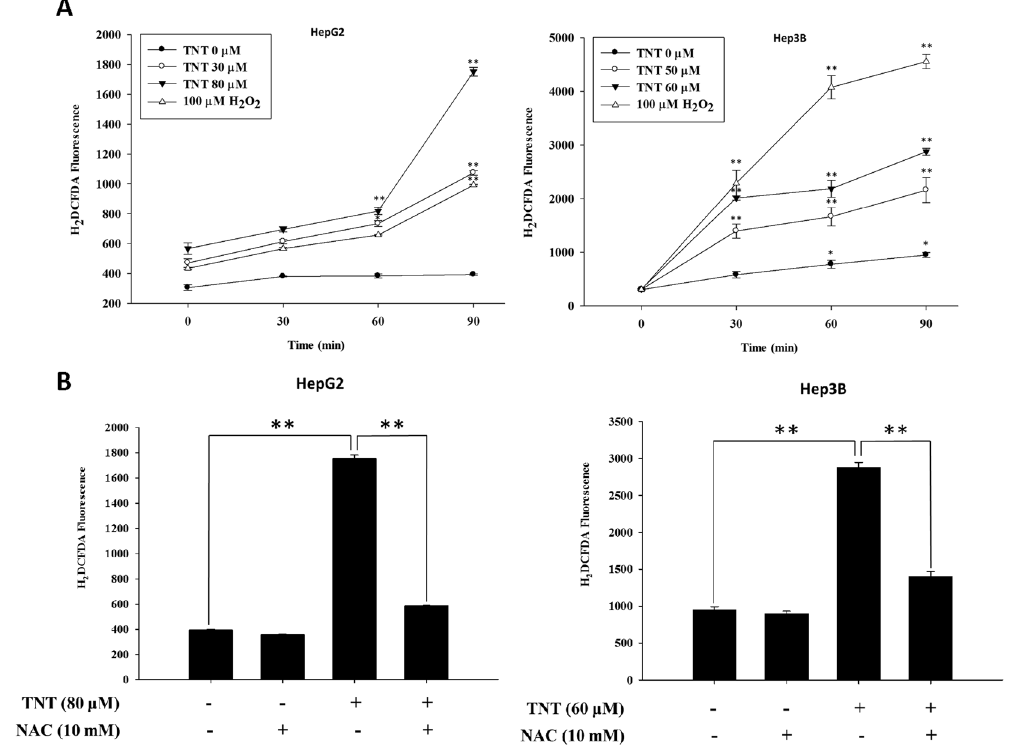
Figure 4. TNT induced the generation of ROS. ( A ) ROS expression levels of HepG2 and Hep3B cells exposed to different doses of TNT for 0 to 90 min. ( B ) The HepG2 cells were treated with 80 μ M TNT, and the Hep3B cells were treated with 60 μ M TNT, both for 90 min in the presence or absence of 10 mM NAC. The values represent the mean ± SD and were derived from at least three independent experiments. Triplicate measurements were performed for each experiment. * P < 0.05; ** P < 0.01 (vs. control